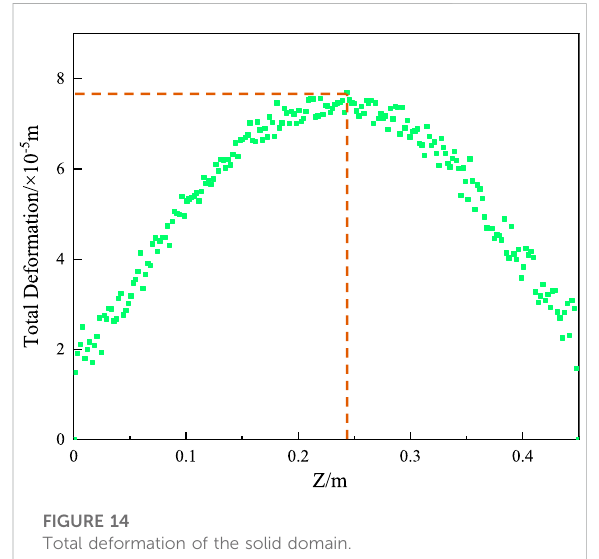
FIGURE 14 Total deformation of the solid